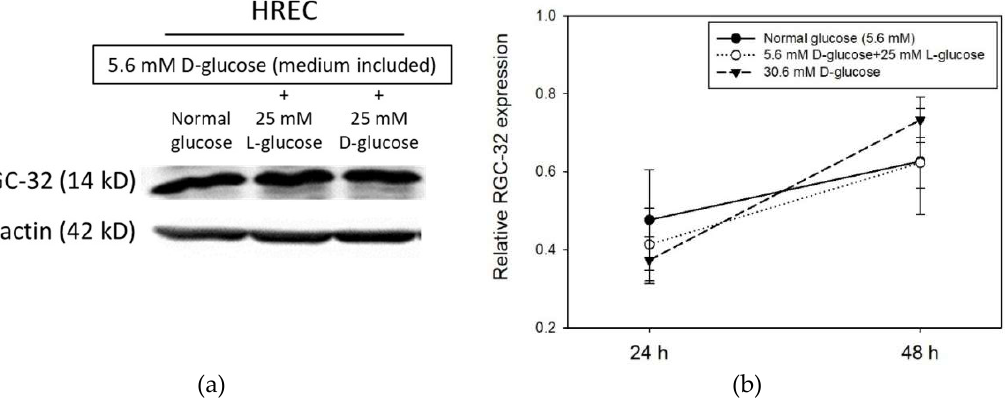
Figure 1. ( a ) Representative western blot image of RGC-32 expression in HREC under high glucose condition for 24 h ( b ) RGC-32 expression relative to that of β-actin in retinal cell under high glucose condition for 24 and 48 h. Data are presented as mean ± SD and differences between means were compared by ANOVA